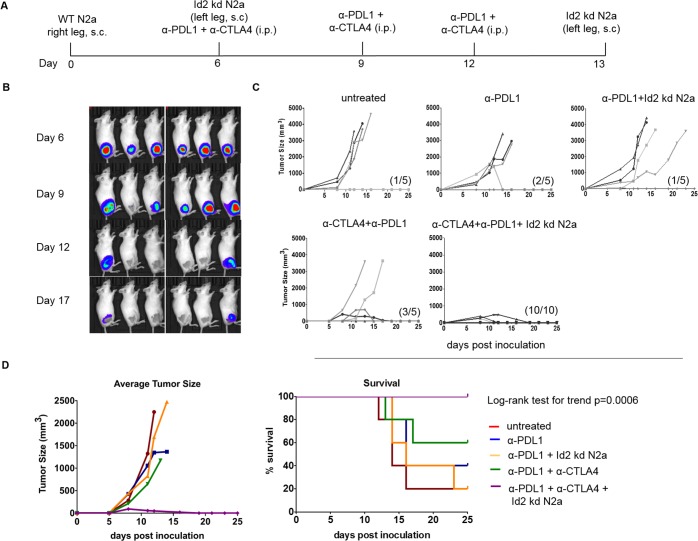
Combined vaccination with immunotherapy cures large established tumors and provides protective immunity.A/J mice were inoculated with 1 × 106 wild-type (WT) N2a, and once tumors were established, the mice were then vaccinated with various combinations of Id2kd-N2a, α-CTLA-4, and α-PD-L1 blocking antibodies. (A) This panel depicts the vaccination protocol and timeline. (B) Tumor eradication in vaccinated mice (n = 6) as detected by chemiluminescent imaging. (C) Tumor growth in various treatment groups following vaccination. Ten out of 10 mice were cured of tumors when Id2kd-N2a vaccine was combined with inhibition of CTLA-4 and programmed cell death-ligand 1 (PD-L1) checkpoints. The graphs depict individual tumor growth over time and cure in parenthesis. (D) Average tumor growth (left panel) and survival (right) are markedly improved in the group receiving a combination of Id2kd N2a, α-CTLA-4, and α-PD-L1 when compared with other treatments (p = 0.0007 for average tumor growth in untreated versus α-PD-L1+α-CTLA-4+Id2kd N2a, p = 0.0005 for WT N2a +α-PD-L1 versus full combination, p = 0.0025 for WT N2a +α-PD-L1+Id2kd N2a versus full combination, 2-way repeated measures ANOVA analysis, left panel; right panel p = 0.0006 for survival trend, log-rank test; p = 0.0007 in untreated control versus α-PD-L1+α-CTLA-4+Id2kd N2a, p = 0.007 in α-PD-L1 versus combination, p = 0.0008 in α-PD-L1+Id2kd N2a versus combination, p = 0.0034 in α-PD-L1+α-CTLA-4 versus combination treatment, log-rank test).